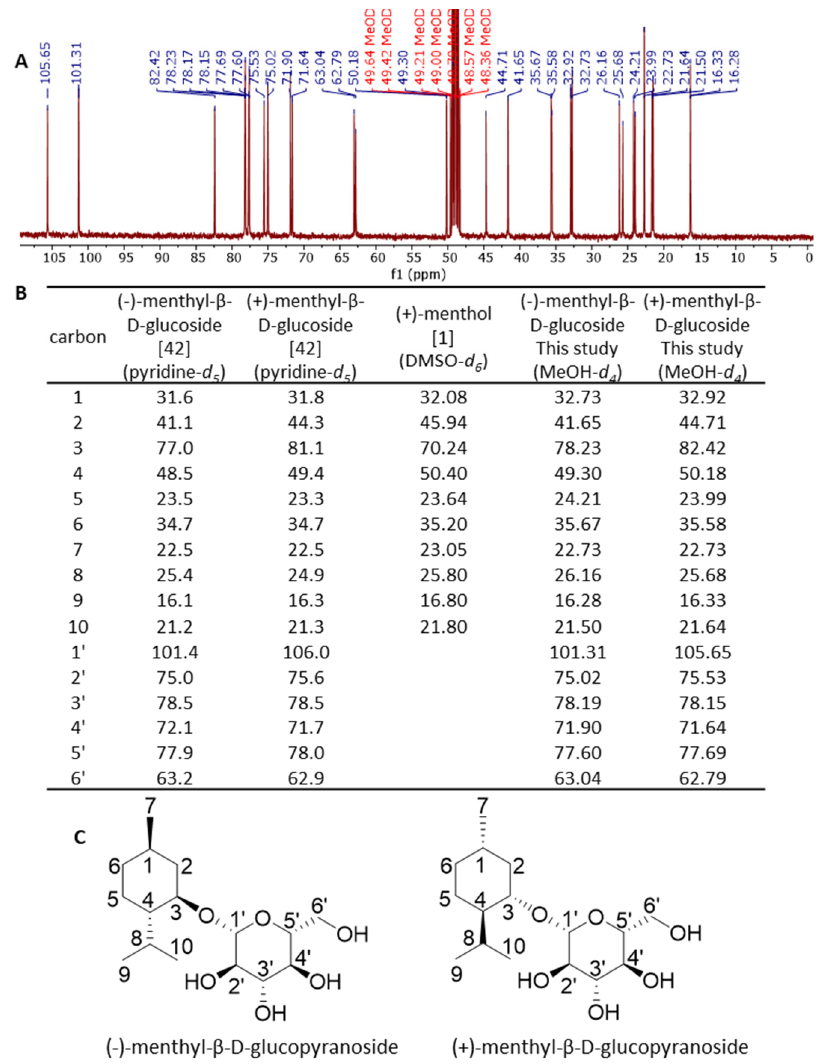
Figure 4. 13 C NMR analysis of biotransformation products formed from ( ± )-menthol by UGT93Y1 whole-cell biocatalysis. NMR spectrum of products produced from ( ± )-menthol ( A ). Chemical shifts ( δ ) in ppm of ( ‐ ) ‐ and (+) ‐ menthyl ‐β‐ D ‐ glucopyranoside taken from [42] of (+) ‐ menthol from [1] and of the reaction products ( B ). Chemical structures of ( ‐ ) ‐ and (+) ‐ menthyl ‐β‐ D ‐ glucopyranoside ( C ).